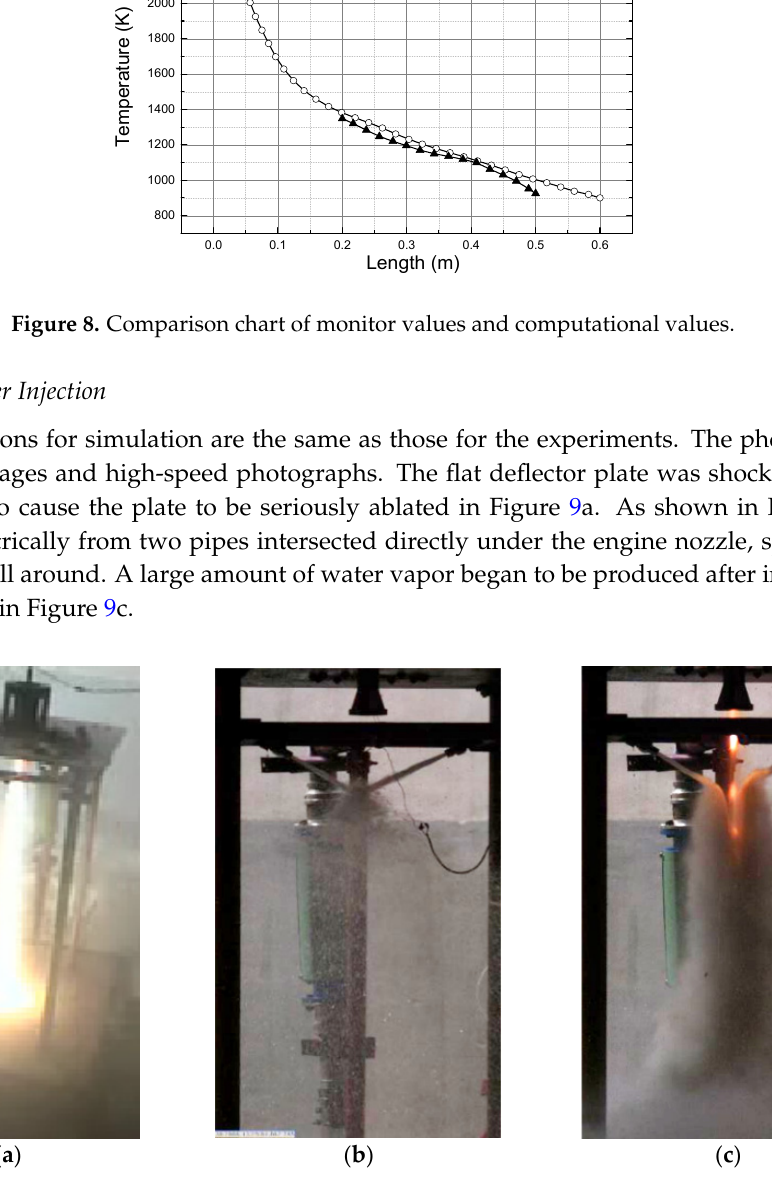
Figure 9. ( a ) Jet flow model without water; ( b ) Water injection model without jet flow; ( c ) Water injection model with jet flow.